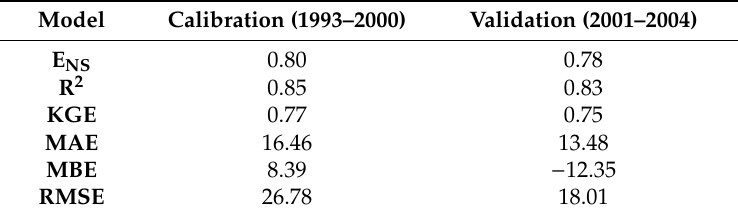
Table 3. Model statistical and performance indicators for streamflow simulations in the calibration and validation periods.